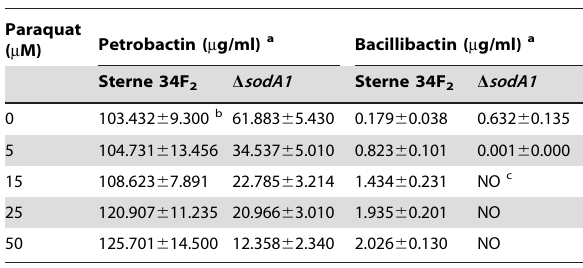
Table 2. Quantification of the Bacillus anthracis siderophores petrobactin and bacillibactin obtained from the IDM cultures of the strains Sterne 34F 2 and D sodA1 with the addition of different concentrations of